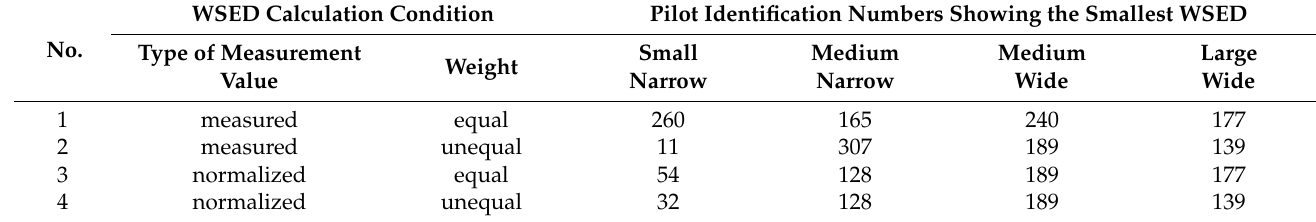
Table 3. Representative pilot identification numbers showing the smallest weighted sum of Euclidean distance (WSED) for each sizing category for different WSED calculation conditions.